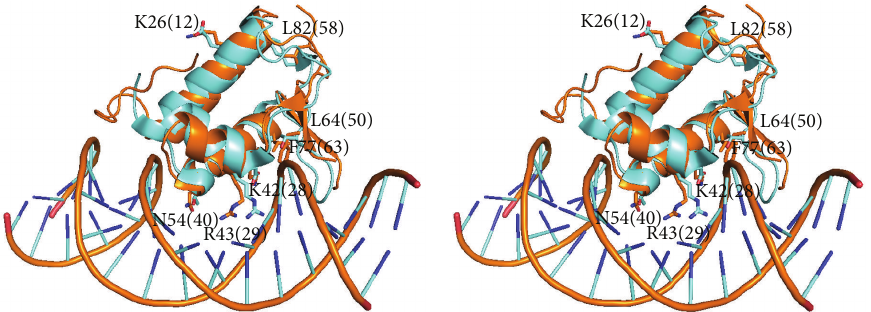
Figure 4: Stereo superposition between the wHTH domains of GabR from Bacillus subtilis and FadR from E. coli . Stereo superposition between the wHTH domains of GabR from Bacillus subtilis (orange cartoon, PDB code 4TV7) and of FadR from E. coli (cyan, PDB code 1H9T). GabR and FadR residues discussed in the text are displayed as sticks. Labels denote GabR residues with amino acid single letter code. Numbering refers to GabR structure and to Figure 3 (in parentheses). Table 2 reports the correspondence between the residues and their numbering. In particular, Arg29 corresponds to GabR Arg43 and FadR Arg35. DNA phosphate backbone is displayed as orange wire while bases are depicted with cyan and blue